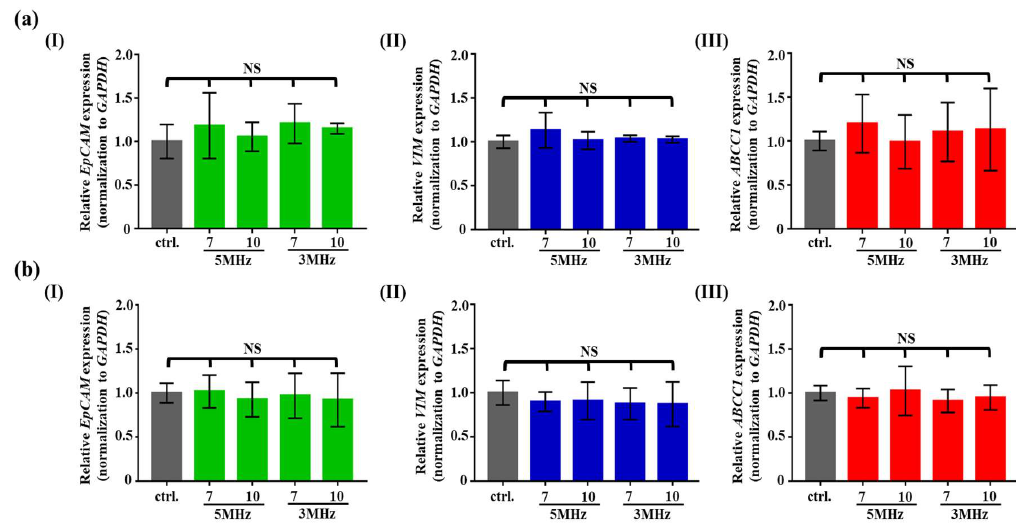
Figure 5. The comparison of relative gene expression ((I) EpCAM , (II) VIM , and (III) ABCC1 genes) of ( a ) the PC-3 cancer cells and ( b ) the SK-BR-3 cancer cells treated with the ODEP field with varied electrical conditions (voltage magnitude and frequency: 7 and 10 Vpp and 3 and 5 MHz, respectively) (NS—No significant difference ( p > 0.05).